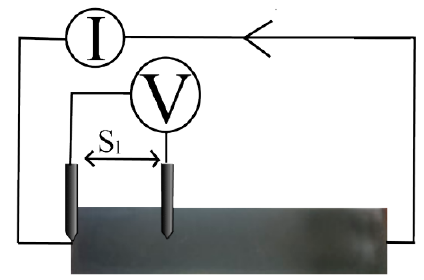
Figure 3. Four-probe line resistance measurement method.